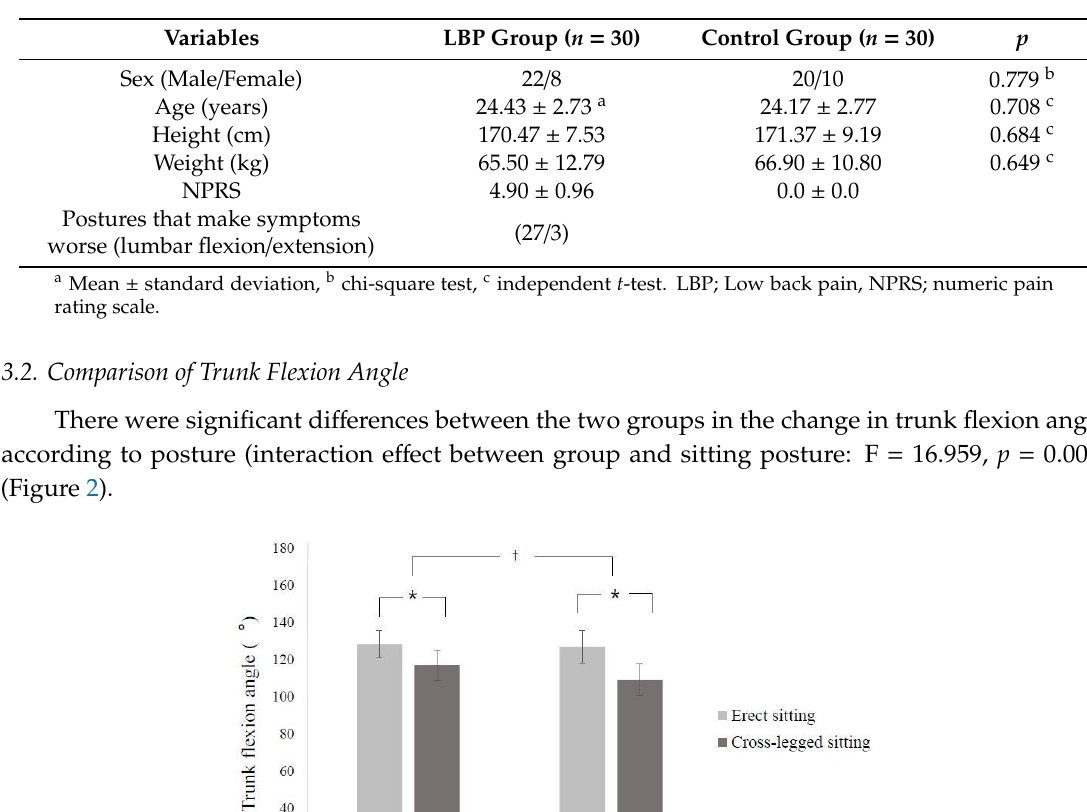
Table 1. Common and clinical characteristics of the subjects ( N = 60).